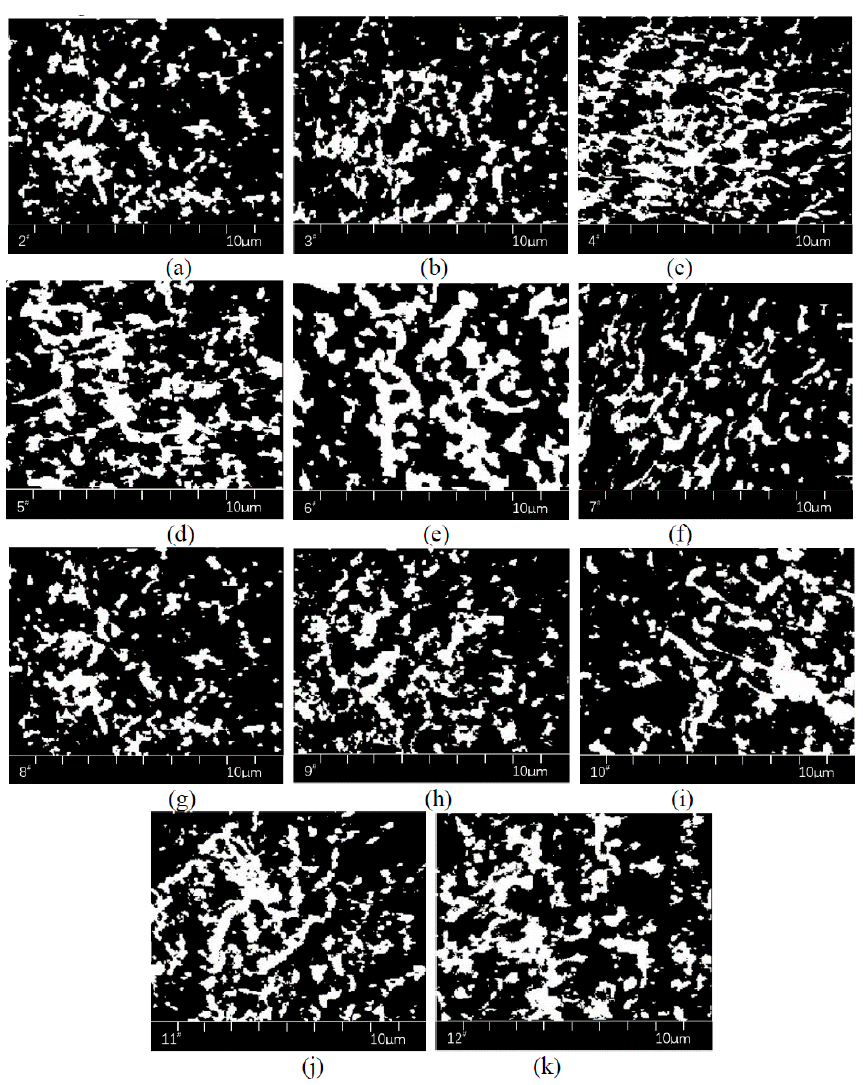
Figure 6. The representative binary image of direct-to-plant SBS modified bitumen modifier: ( a ) 2 # ,